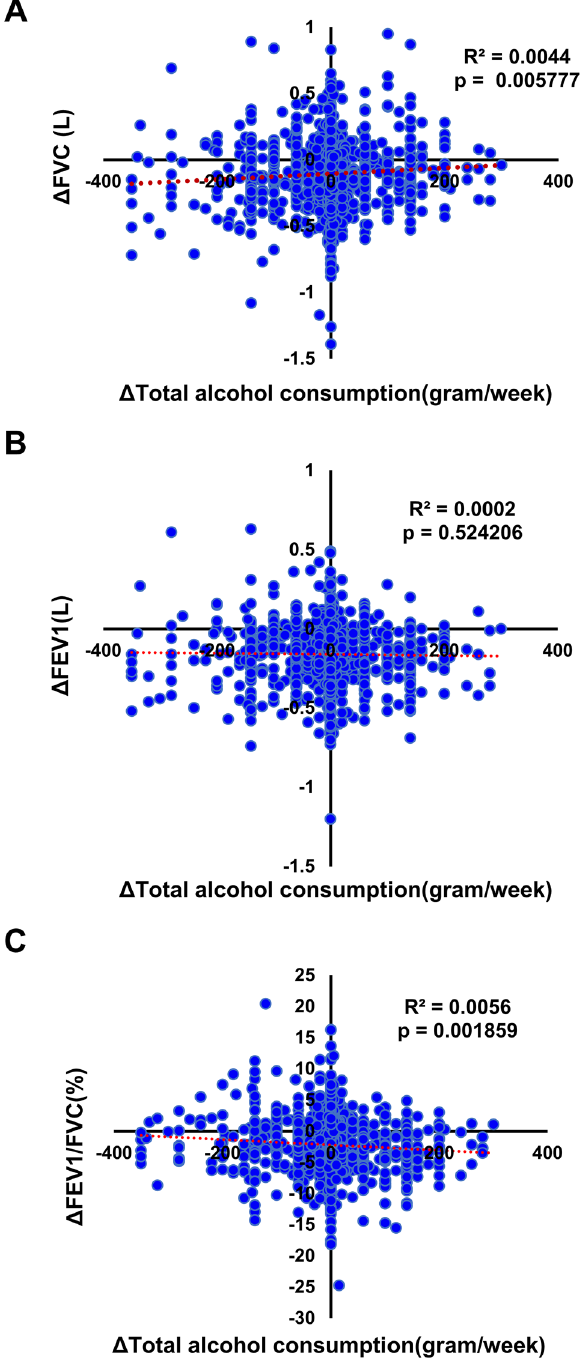
Figure 3. Increases in moderate alcohol consumption protect subjects against time-related physiological deterioration of FVC and FEV1, but not the FVC/FEV1 ratio. (A) Time course of the effect of changes in alcohol intake on time-related deterioration of FVC. The X axis represents the change in the total alcohol consumption and the Y axis represents the change in FVC from the same persons in 2013 and 2018 in all subplots. The red dotted line represents an approximate straight line. (B) Time course analysis of the effect of changes in alcohol intake on time-related deterioration of FEV1. (C) Time course analysis of the effect of changes in alcohol intake on time-related deterioration of the FEV1/FVC